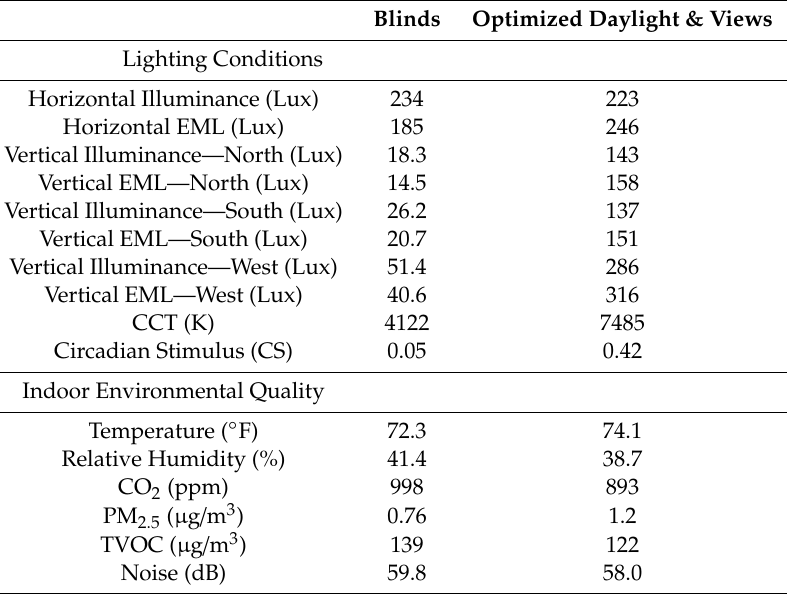
Table 2. Environmental conditions in the two o ffi ce environments.